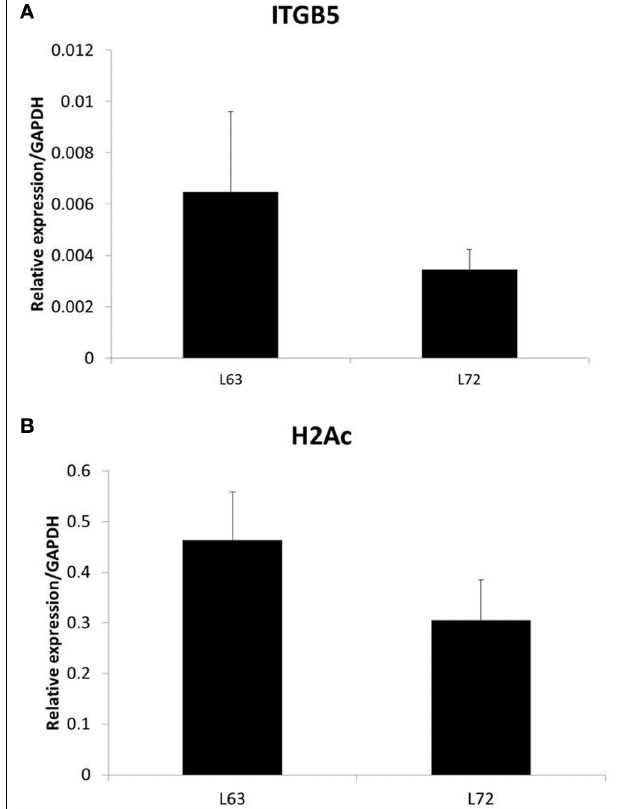
FIGURE 2 | Expression of ITGB5 (A) and H2Ac (B) in non-infected chicken samples. N = 4 for each group. Error bar = STD.